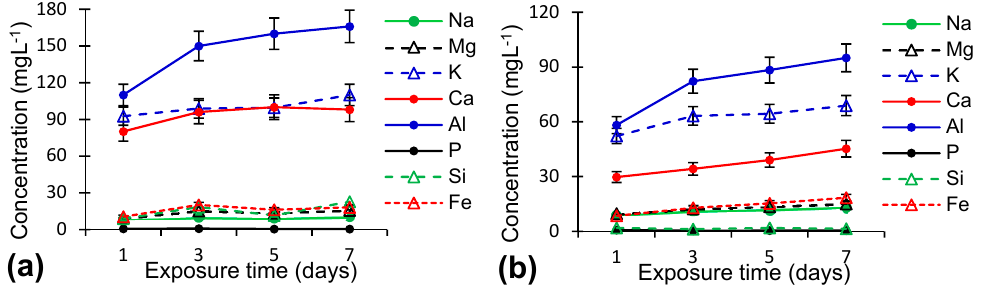
Figure 4. Influence of exposure time on the element dissolution with a 10:1 ( w / v ) zeolite/SGF ratio for ( a ) raw zeolite (RZ), ( b ) zeolite thermally treated at 800 o C. The increase of the elements released with the increasing zeolite to SGF ratio (Figure 5) was observed for all studied elements except P, as well as for all thermal treatments. This increase is sharper for Al, K, and Ca than for the other elements, as these elements are released preferentially from the zeolite structure.